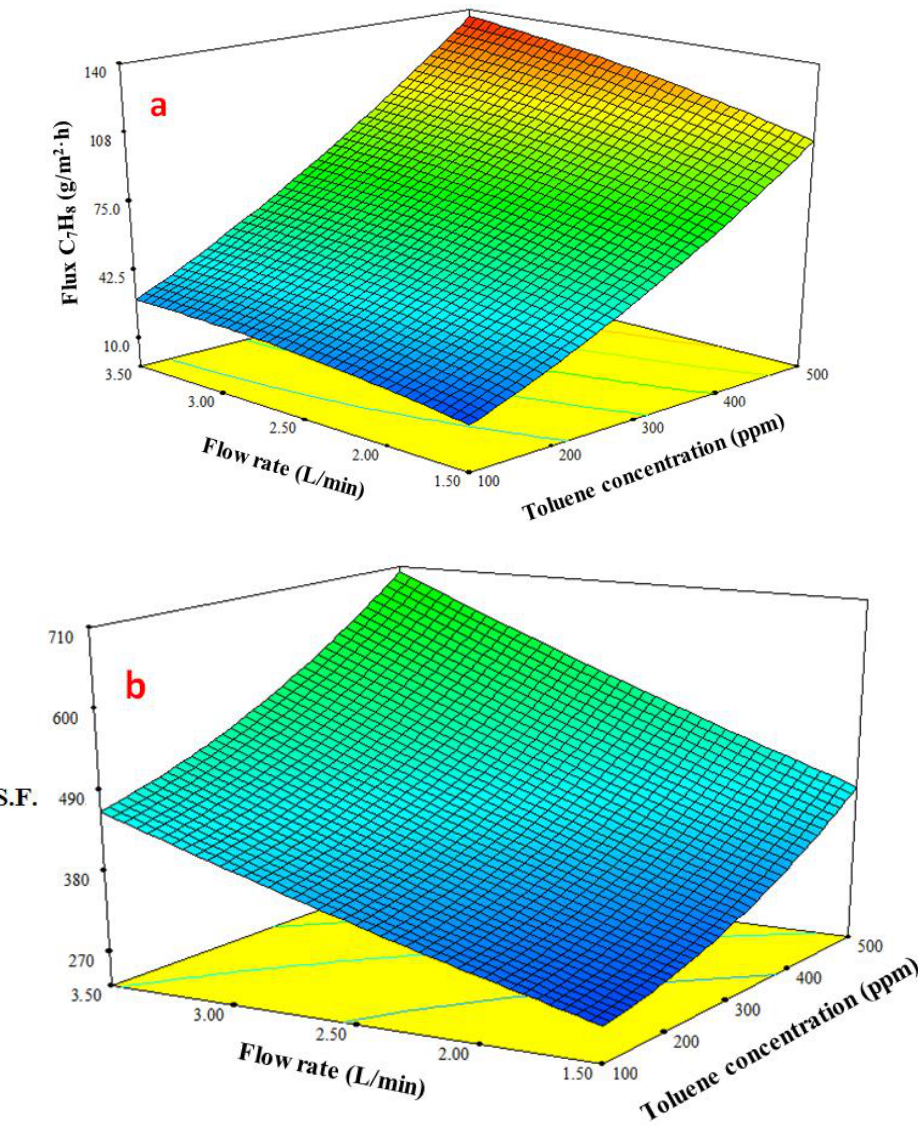
Figure 9. Effect the feed flow and concentration on ( a ) toluene flux and ( b ) separation factor ( S.F. ) at a temperature of 40 ° C.